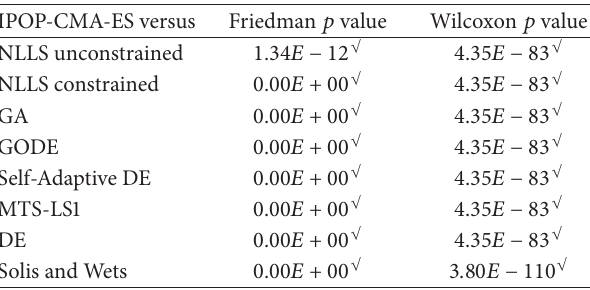
Table 13: Corrected 𝑝 values according to Holm’s method (IPOP- CMA-ES is the control algorithm) for the 8-term Gauss series.